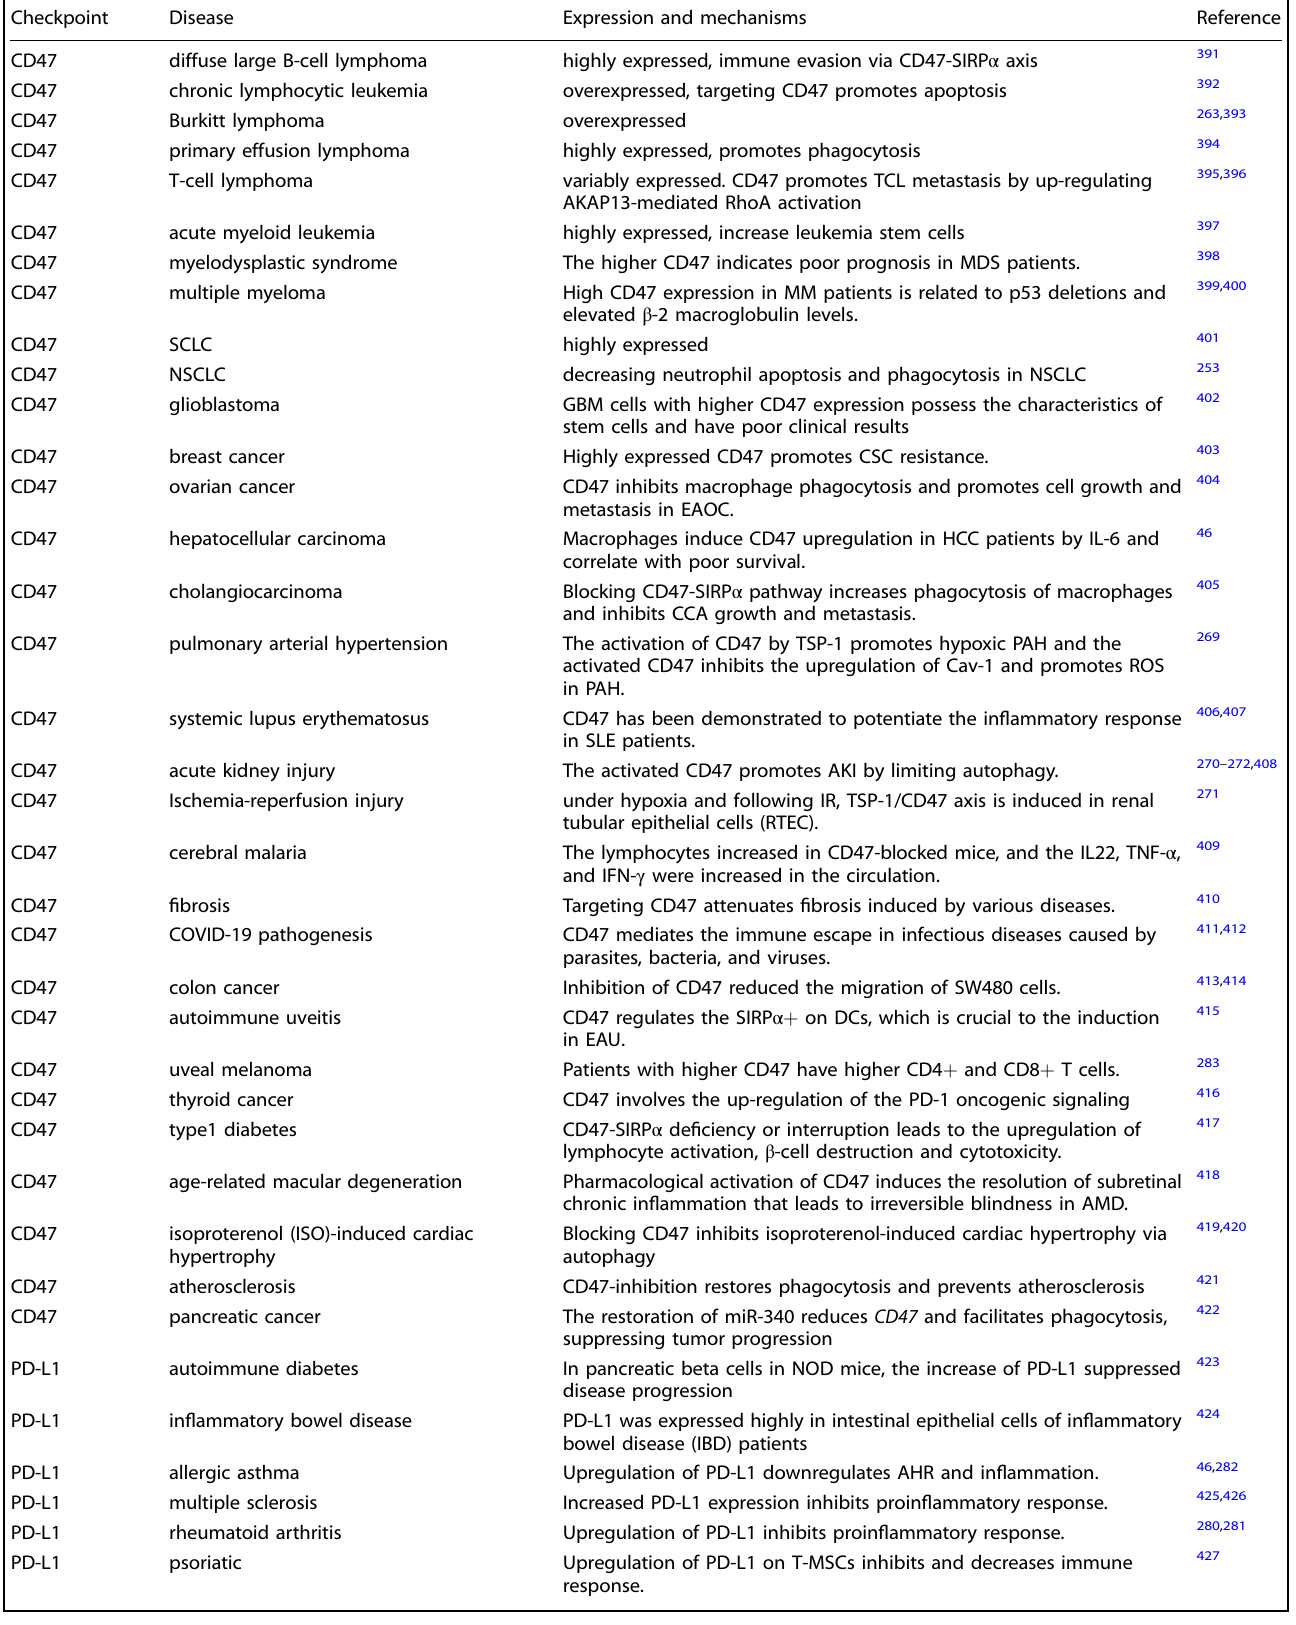
Table 1. Phagocytosis checkpoints expression and working mechanisms in various diseases Checkpoint Disease Expression and